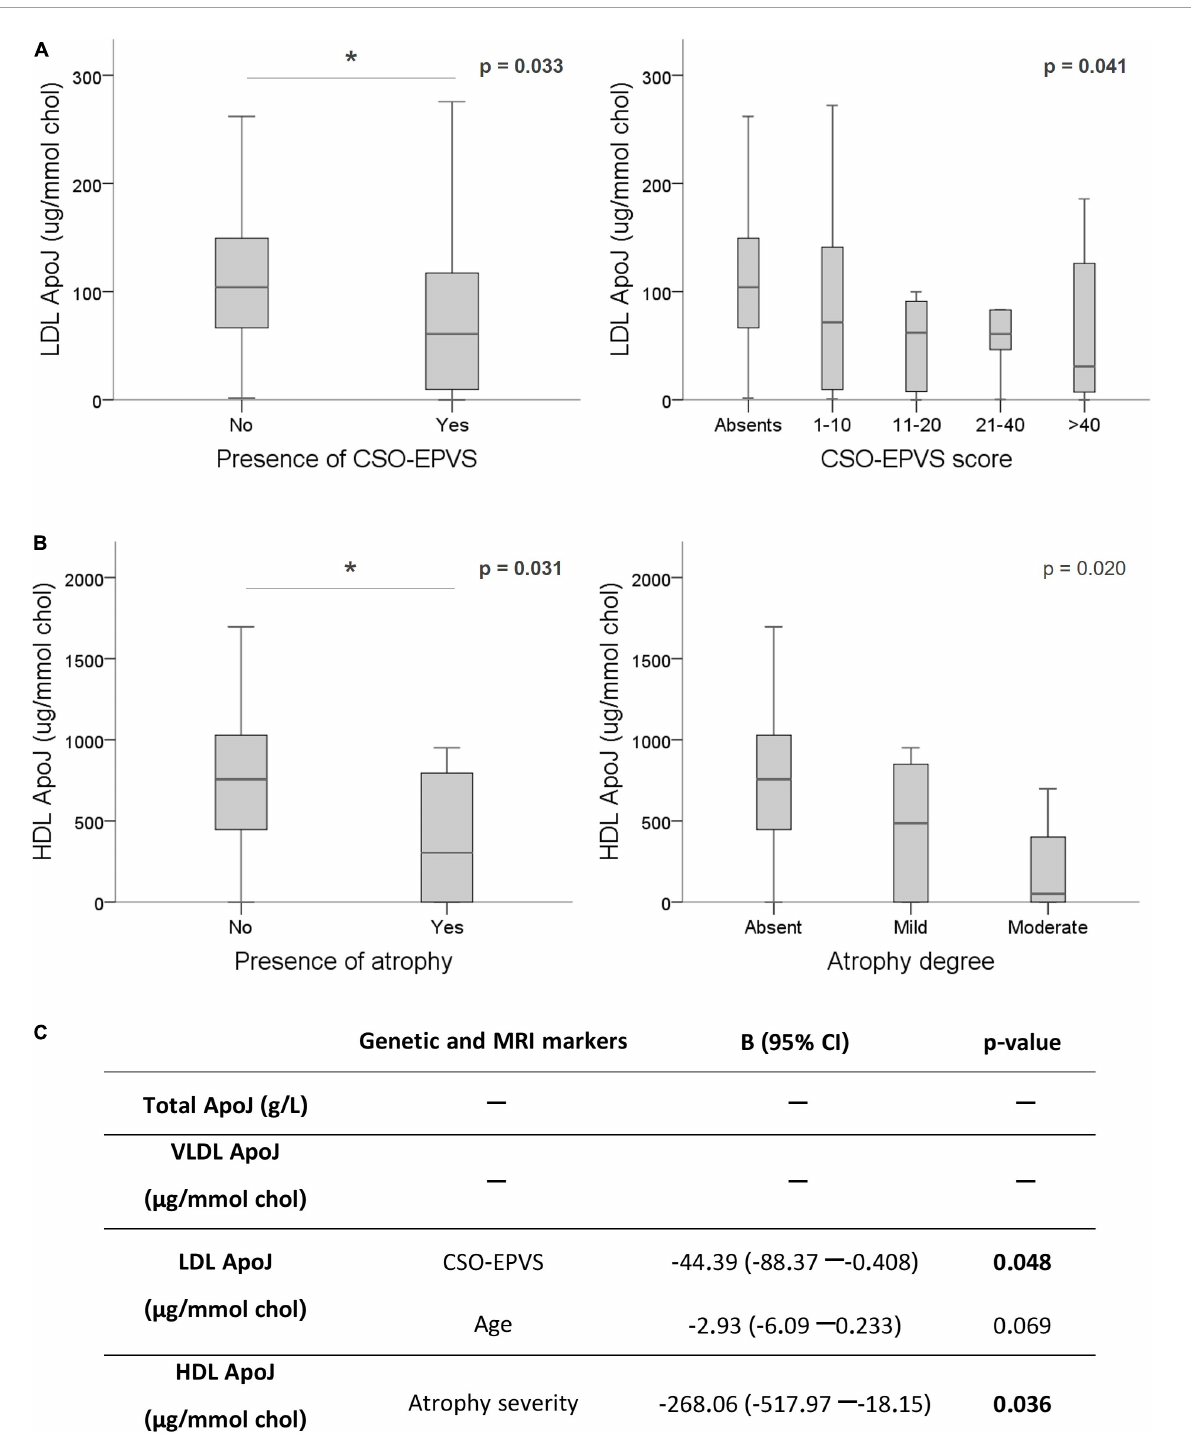
significantly associated with a lower burden of periventricular WMH and CAA-SVD score and rs11136000 (T) with a reduced number of CMB, in line with a previous study of our group where rs11136000 (T) was associated with the absence of lobar CMBs